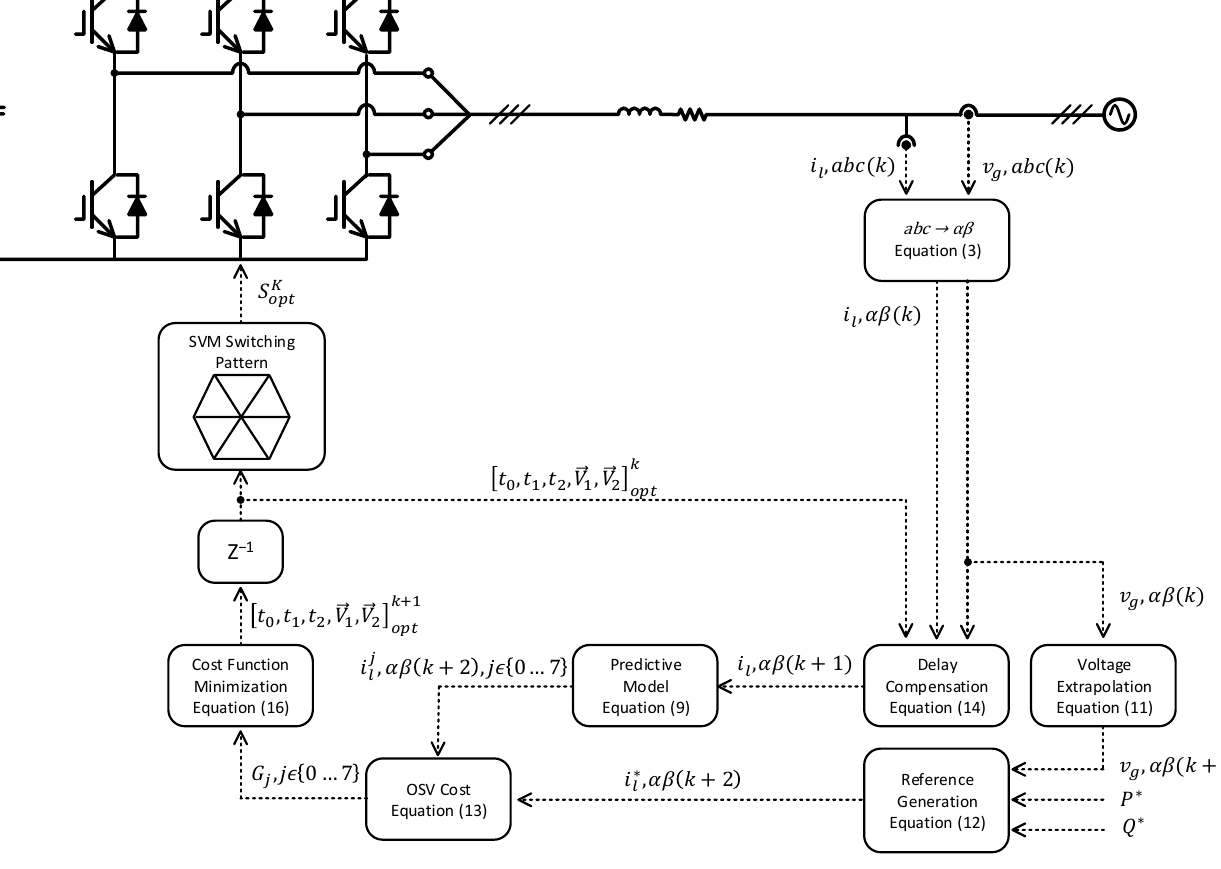
Figure 7. Block diagram for the M2PC control of three-phase two-level VSI.